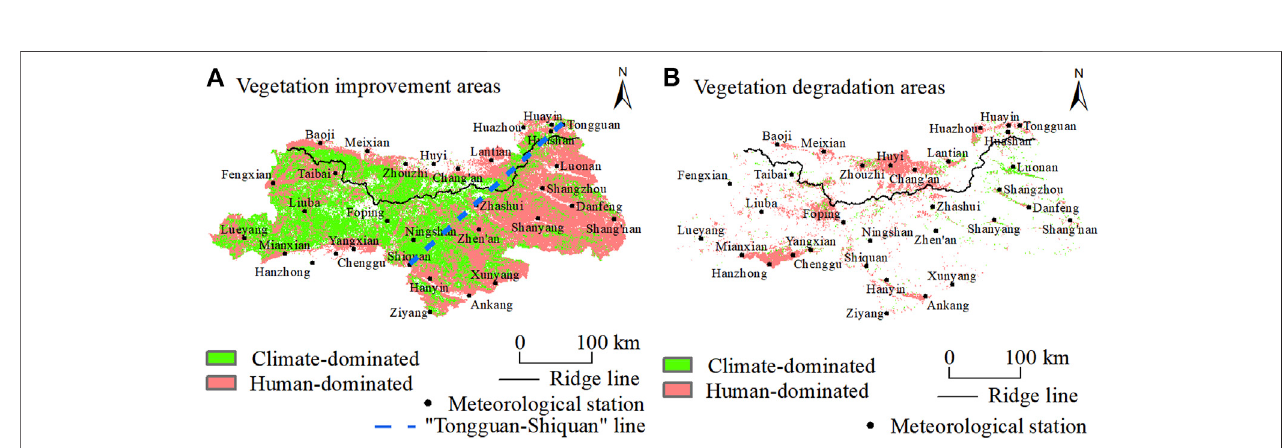
FIGURE 7 | Spatial distributions of the climate and human dominated in the Qinling Mountains. (A) Vegetation improvement areas and (B) vegetation degradation areas.